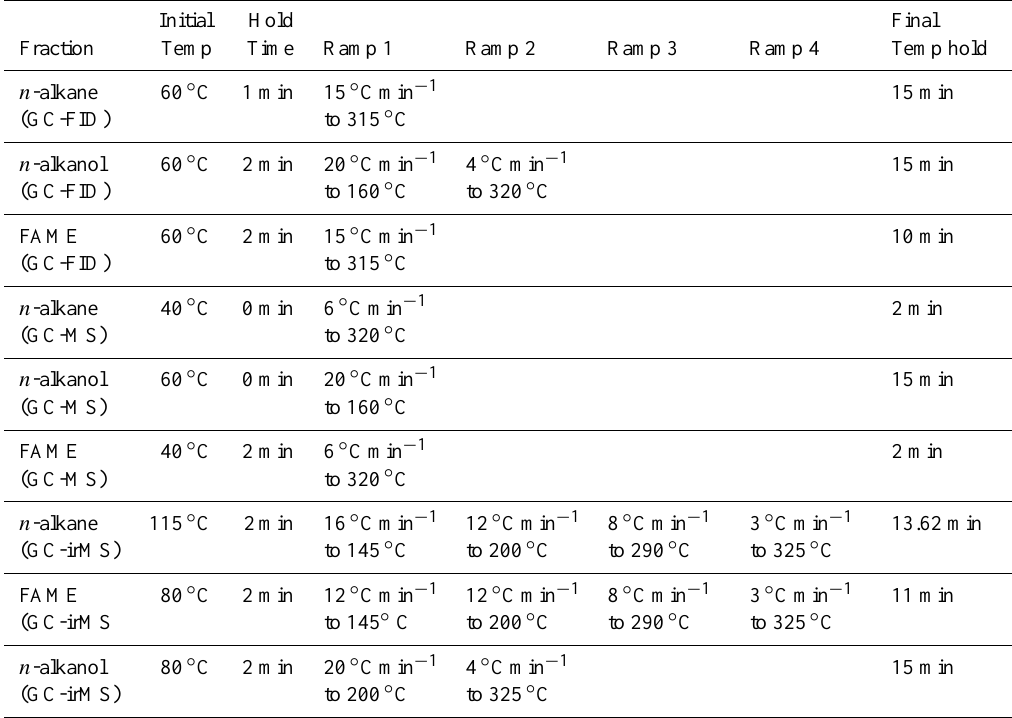
Table 1. Temperature conditions for GC, GC-MS and GC-IRMS for the different compound classes examined in this study. Initial Hold Final Fraction Temp Time Ramp 1 Ramp 2 Ramp 3 Ramp 4 Temp